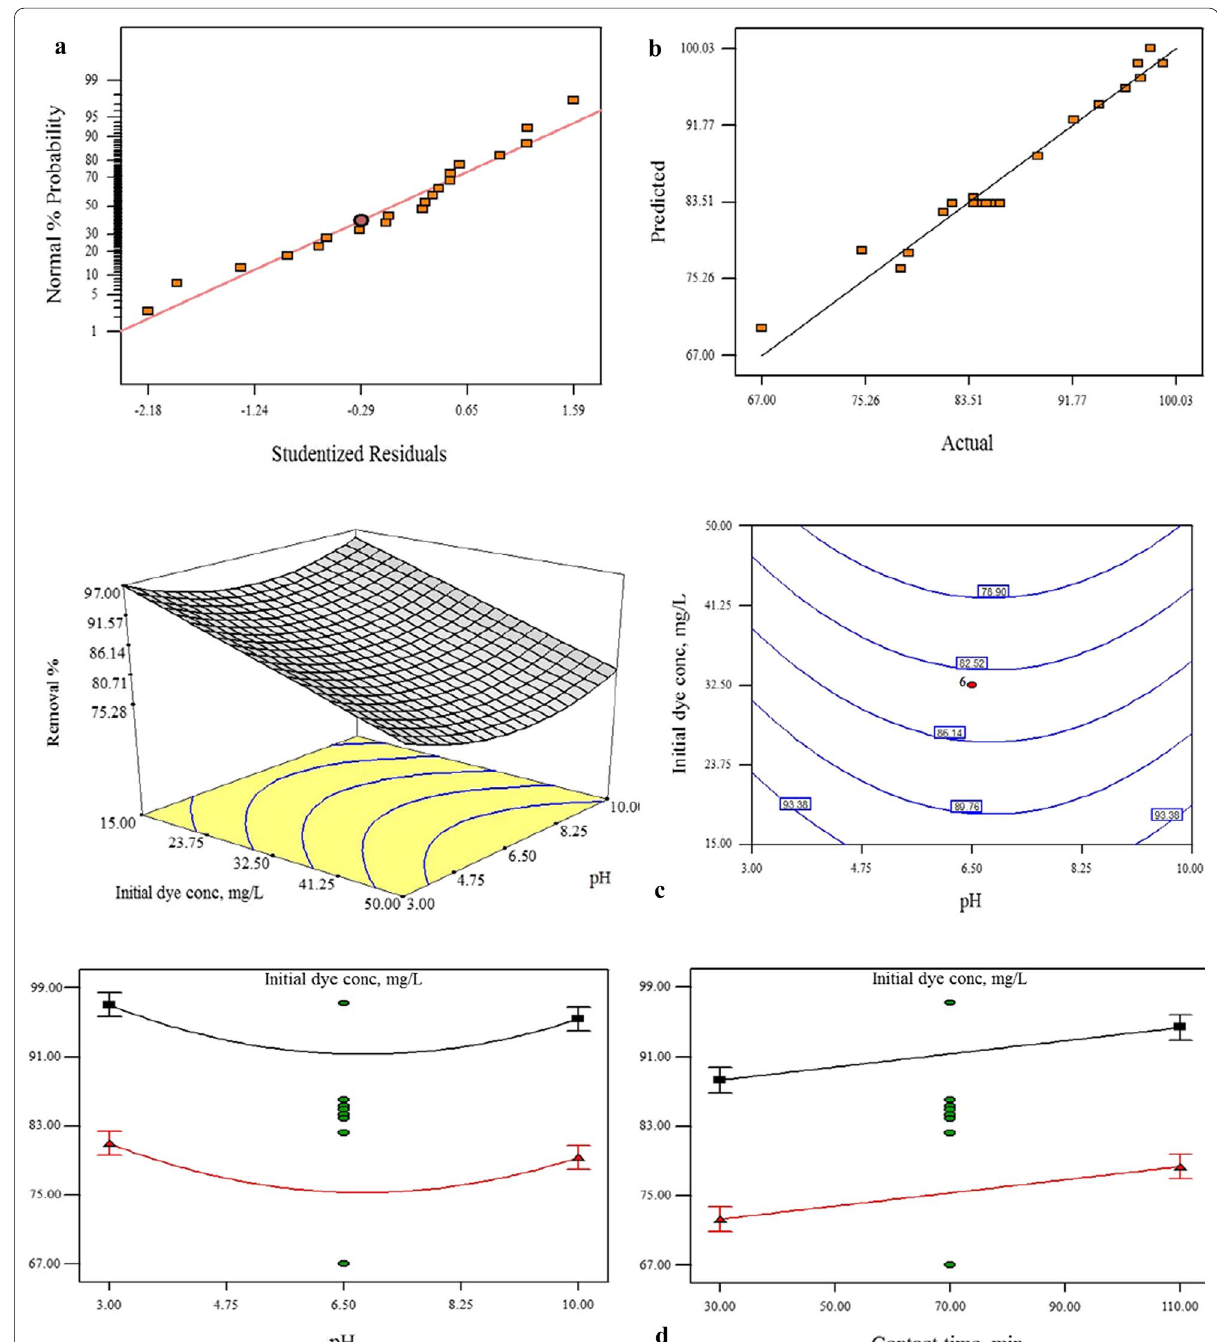
Fig. 2 a Normal plot of the residuals, b actual values of the response versus the predicted values: c simultaneous effect of initial dye concentration and effluent pH on Dye removal % at the center value of time, and the model contour, d interaction relationships between the model